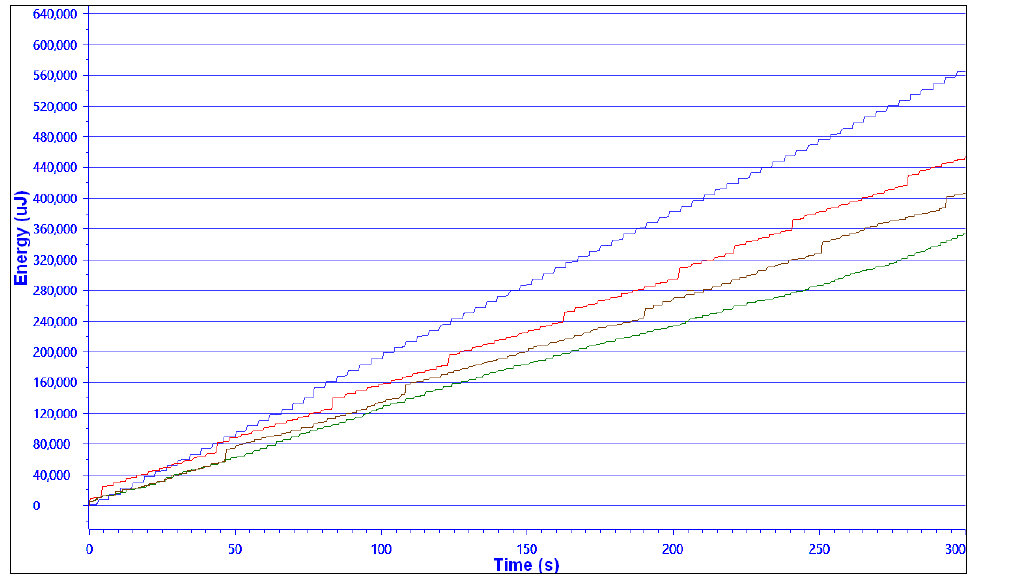
Figure 11. Energy measurement graph—From top to bottom: MAC-only ( blue ) vs. Hybrid FRR = 0.1 ( red ) vs. Hybrid FRR = 0.05 ( brown ) vs. RFF only ( green